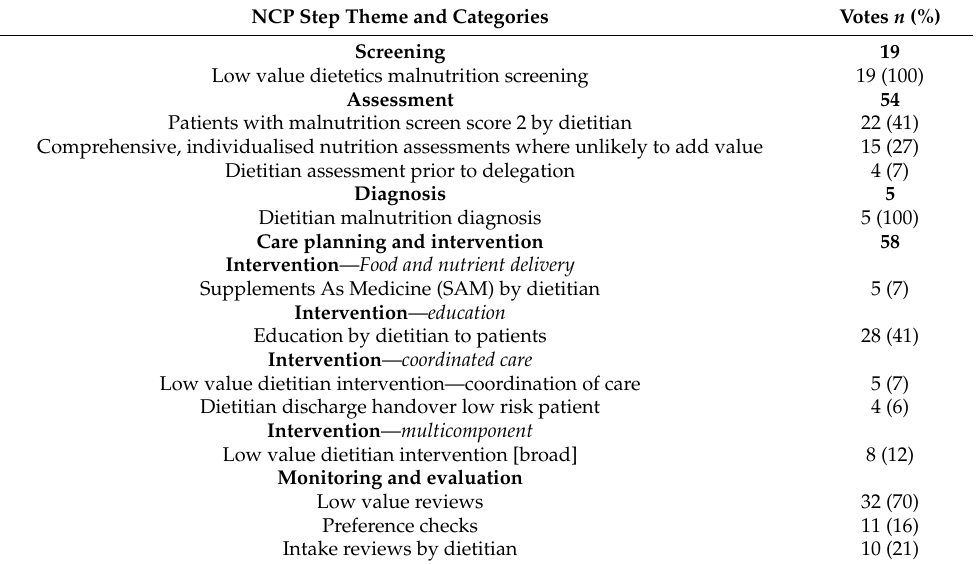
Table 3. Dietetics activities for de-implementation